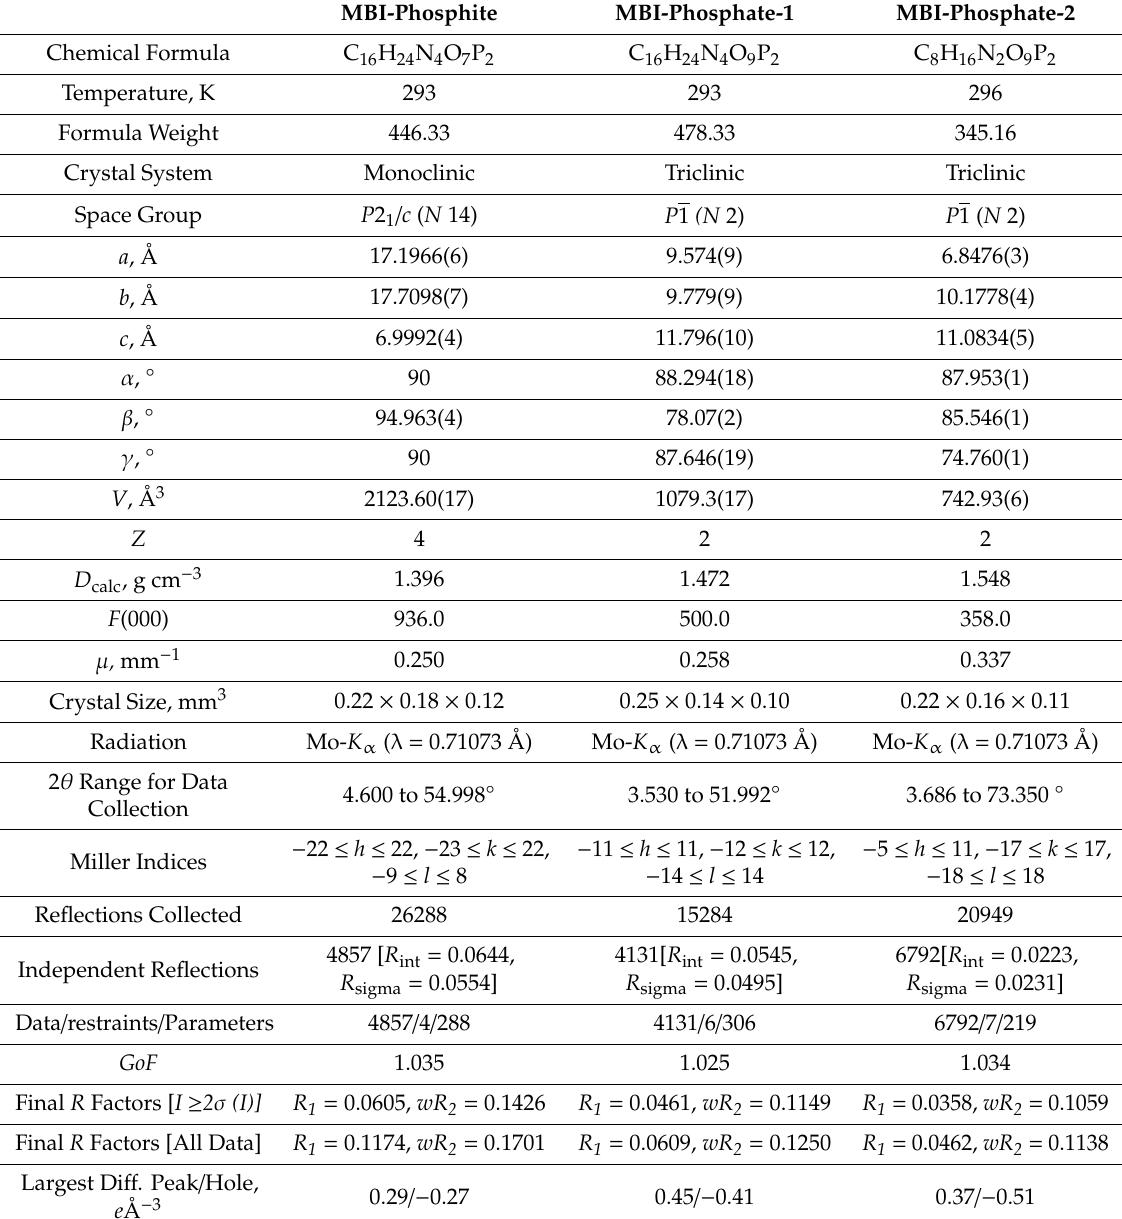
Table 1. Details of crystal data and structure refinement of single